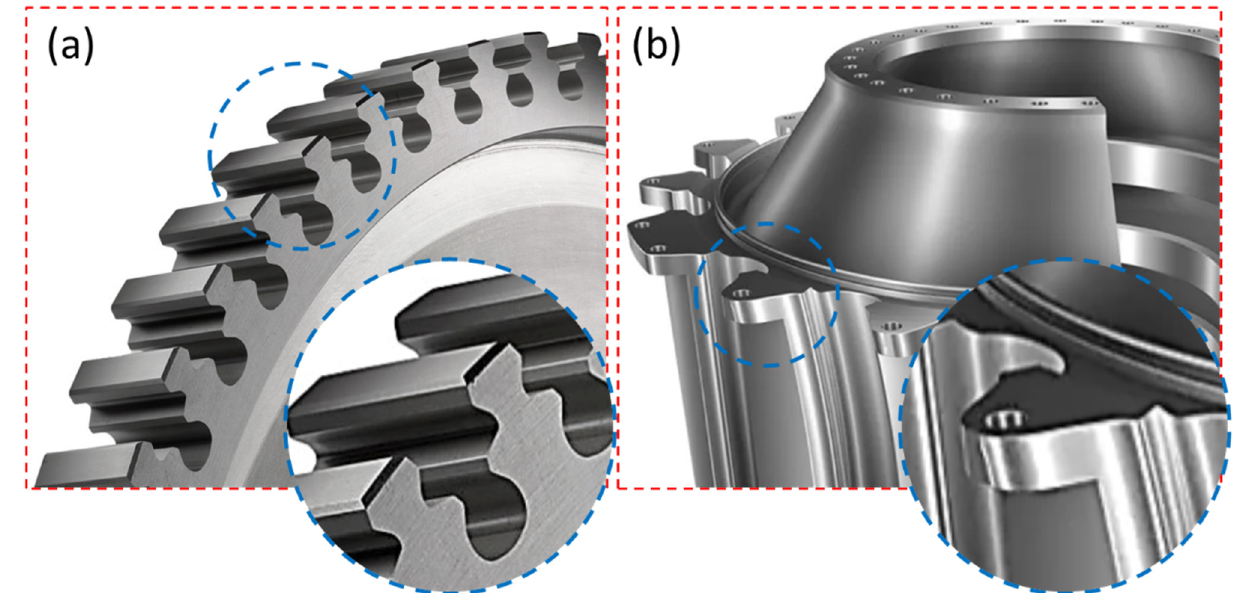
Figure 1. Application of complex profiles used in aero-industry: ( a ) turbine disk firtree profiles of Inconel 718 [6] ; ( b ) fan disk of heat-resistant alloy [11].